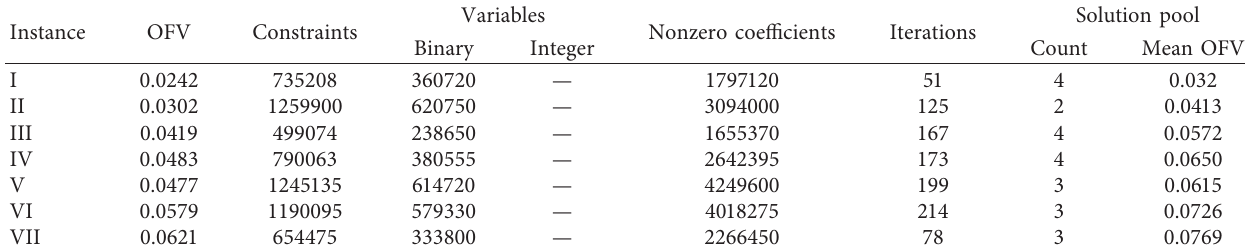
Table 5: The solving statistical information with BYCA-TSIS for the second stage by CPLEX.